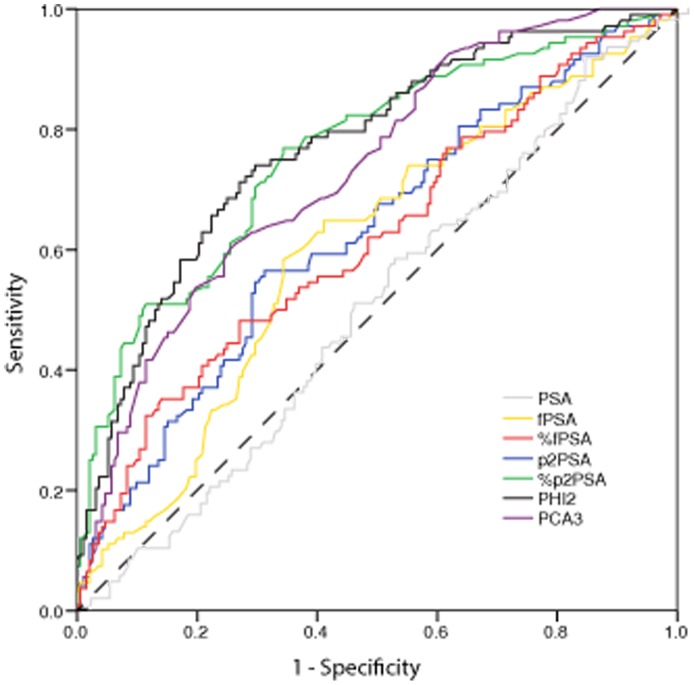
Receiver operating characteristic (ROC) curve for comparing all the analyzed markers as predictor of PCa in first biopsy.